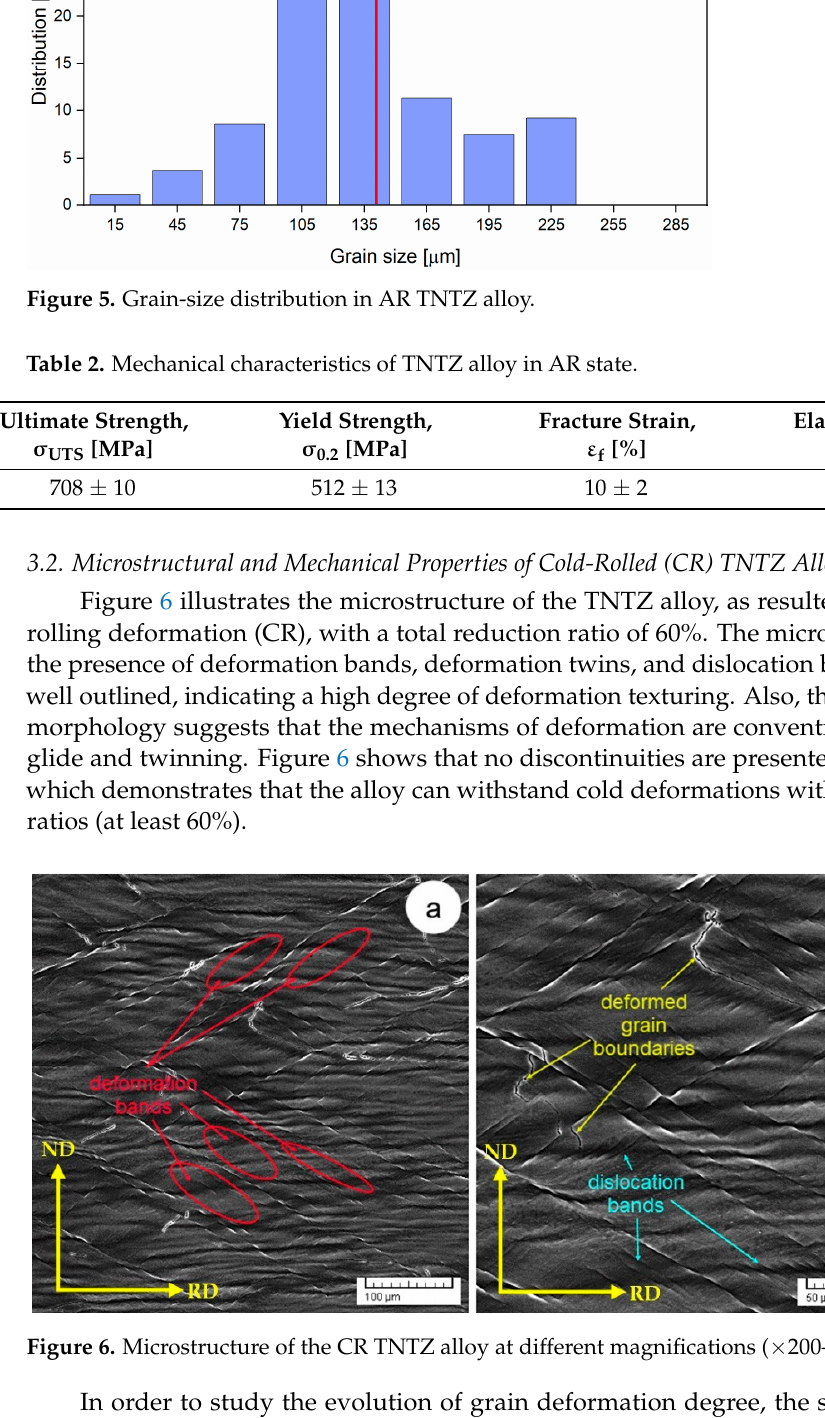
Table 3. Mechanical characteristics of CR TNTZ alloy. Structural State